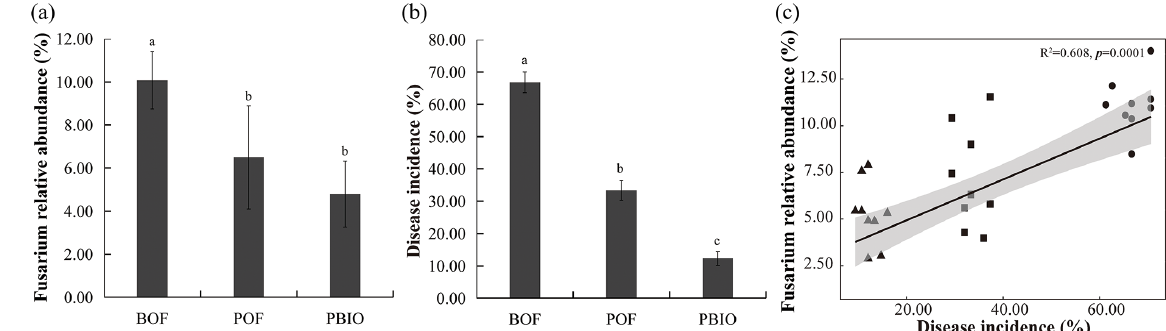
Figure 1. Relative abundance of Fusarium (a) , Fusarium wilt disease incidence (b) , and Pearson correlations between Fusarium wilt disease incidence and Fusarium relative abundance (c) . BOF – banana continuously cropped with OF application; POF – banana–pineapple rotation with OF application in the banana season; and PBIO – ,banana–pineapple rotation with BIO application in the banana season. Bars above the histogram represent standard errors and different letters indicate significant differences ( p < 0 . 05) according to multivariate variance analysis and multiple comparison